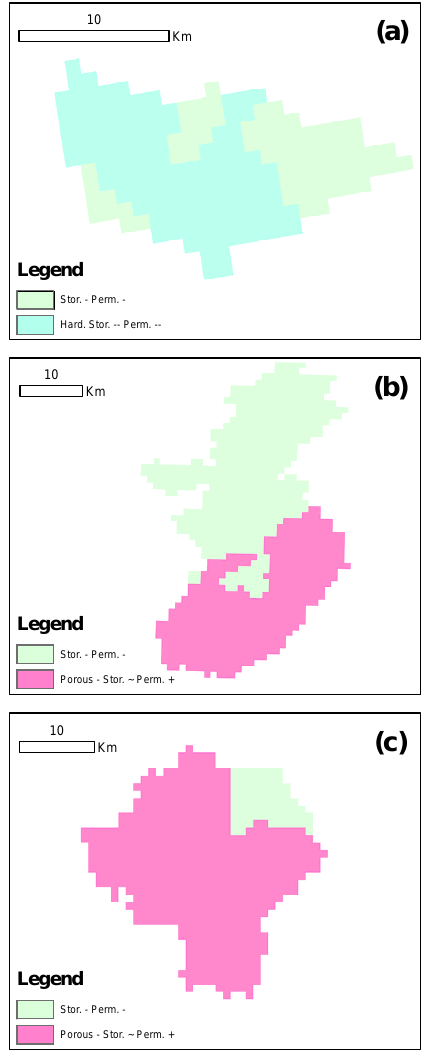
Fig. 3. Soil codes from the World Reference Base (1km × 1km raster library of the European Soil Database, Panagos et al., 2012) in the catchments: (a) Poyo, (b) Upper Iller and (c)